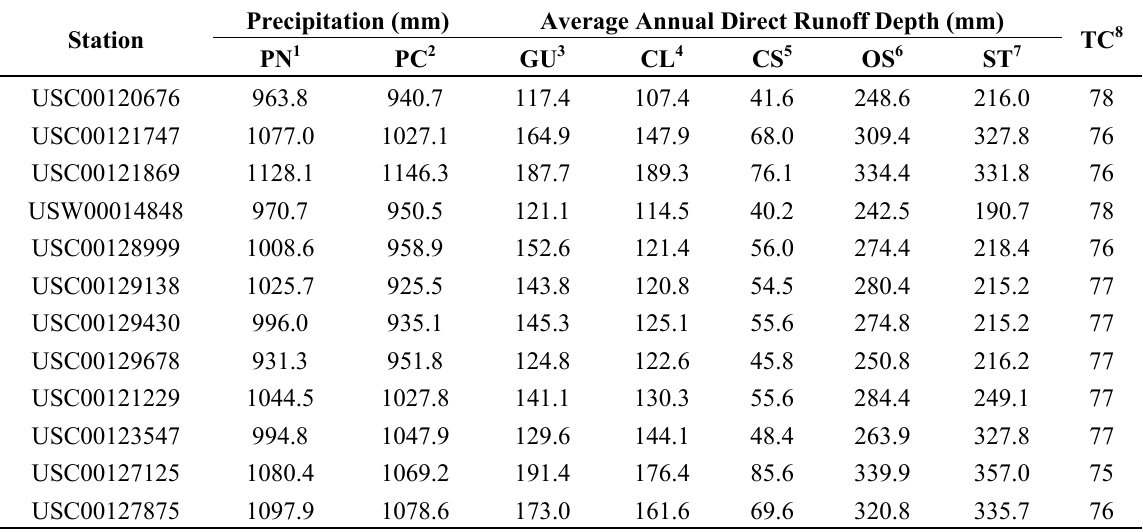
Table 3. Average annual precipitation and direct runoff